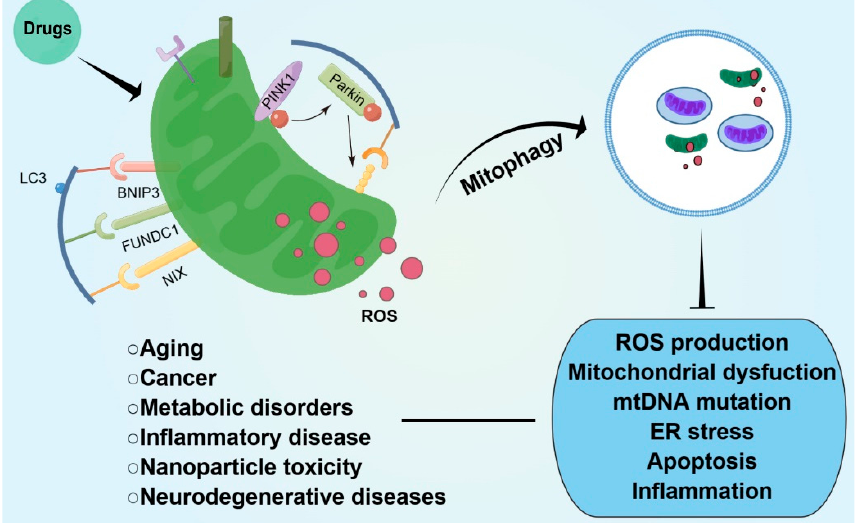
Figure 2. Administration of drugs, which regulate mitochondrial ROS production and mitophagy, improves organismal homeostasis and various disease conditions.